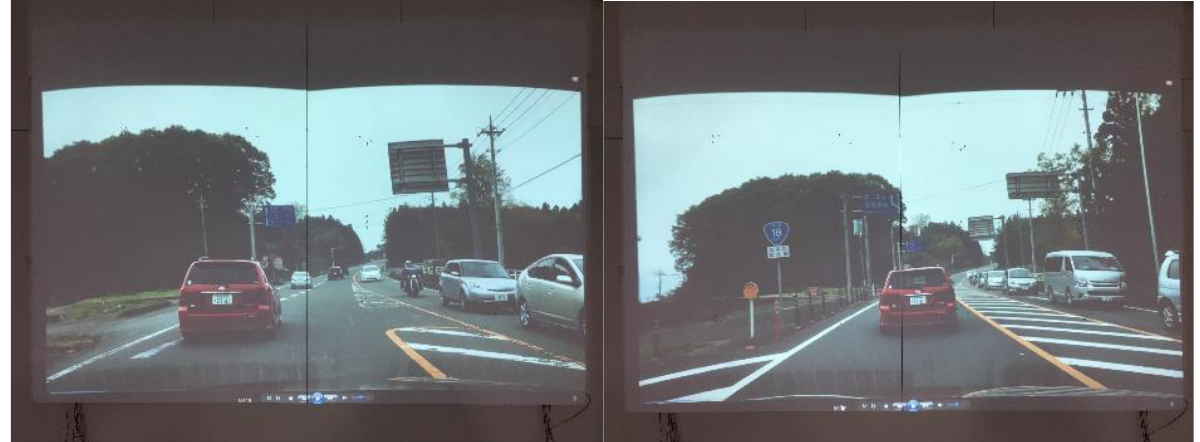
Figure 15: Histogram of distance between the actual eye position and the corrected eye position (